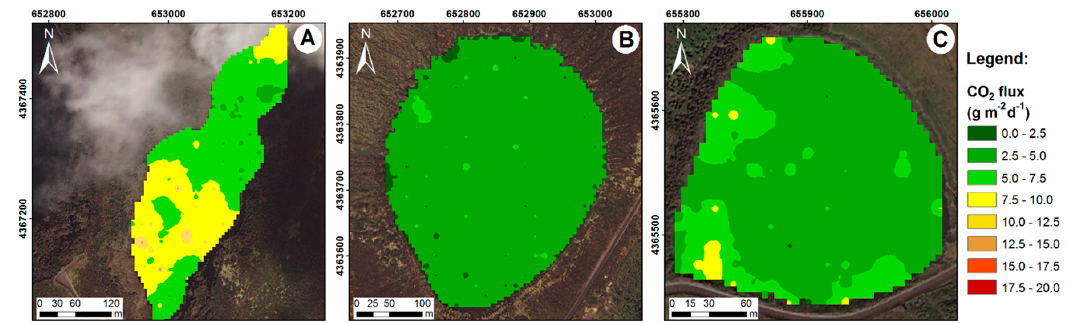
Figure 6. E-type CO 2 flux maps for the Corvo ( A ) and Flores lakes: ( B ) Branca; ( C ) Patos; ( D ) Negra; ( E ) Funda; ( F ) Comprida; ( G ) Rasa; and ( H ) Lomba lakes in first survey (UTM–WGS84, zone 25S; interpolation method—sequential Gaussian simulation (sGs)).